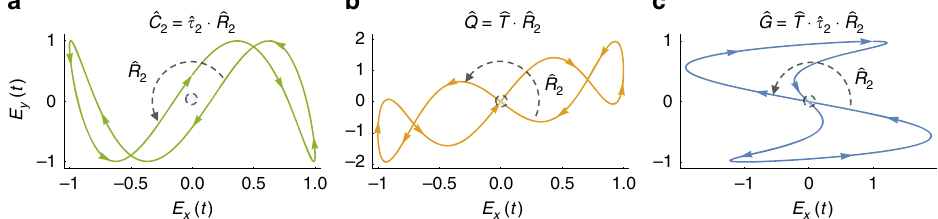
Fig. 2 Order-2 spatiotemporal DSs in (2 + 1)D involving spatial rotations by 180° with examples for each symmetry. ( a ) ^ C 2 symmetry for the example fi eld E ( t ) = sin( ω t ) ^ x + sin(3 ω t + π /7) ^ y , ( b ) ^ Q symmetry for the example fi eld E ( t ) = sin( ω t ) ^ x + (sin( ω t ) + sin(4 ω t )) ^ y , and ( c ) ^ G symmetry for the example fi eld E ( t ) = (sin(2 ω t ) + cos(3 ω t )) ^ x + cos( ω t ) ^ y . The fi elds are represented on Lissajou plots. The spatial parts of the operators is indicated by dashed arrows, colored arrows in the plots indicate the direction of time